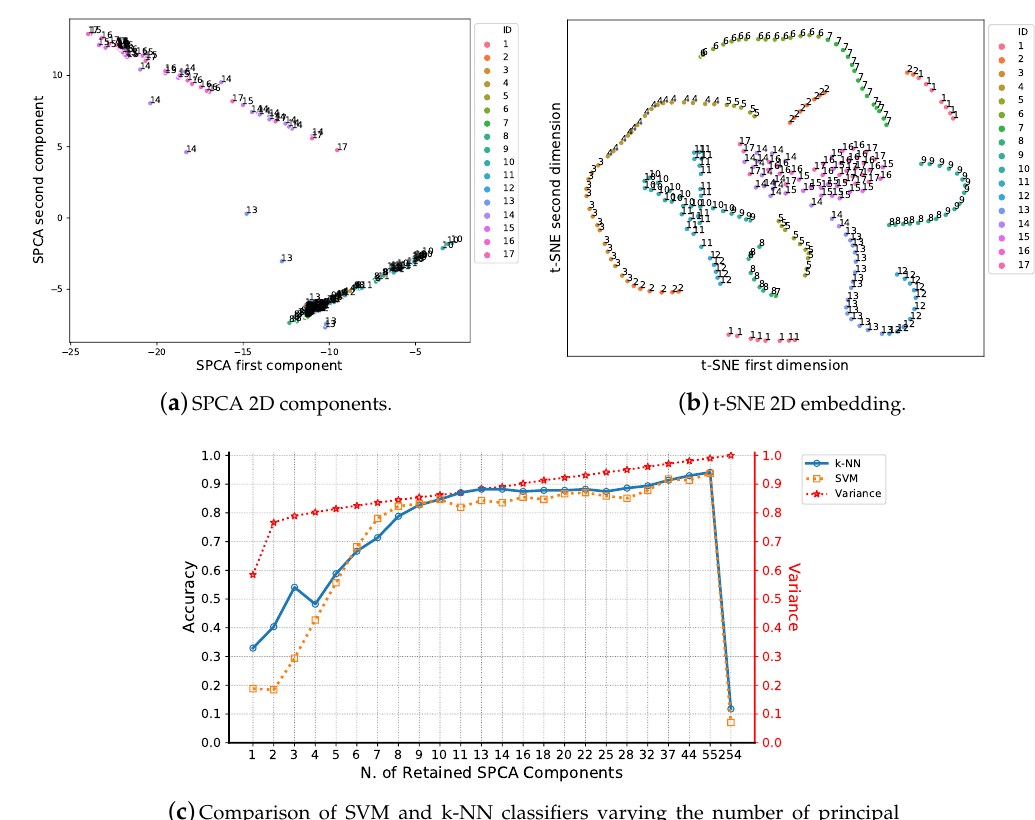
Figure 13. ( a ) represents the 2D embedding obtained with t-SNE using the first 28 components of the SPCA (95% of variance) applied to all the video recordings in UserWGaze dataset grouped together. It is obtained with a value of perplexity 35, early exaggeration 15, and learning rate 200. ( b ) A comparison of the average accuracy resulting from a leave-one-out validation of the solution in [43] and the proposed